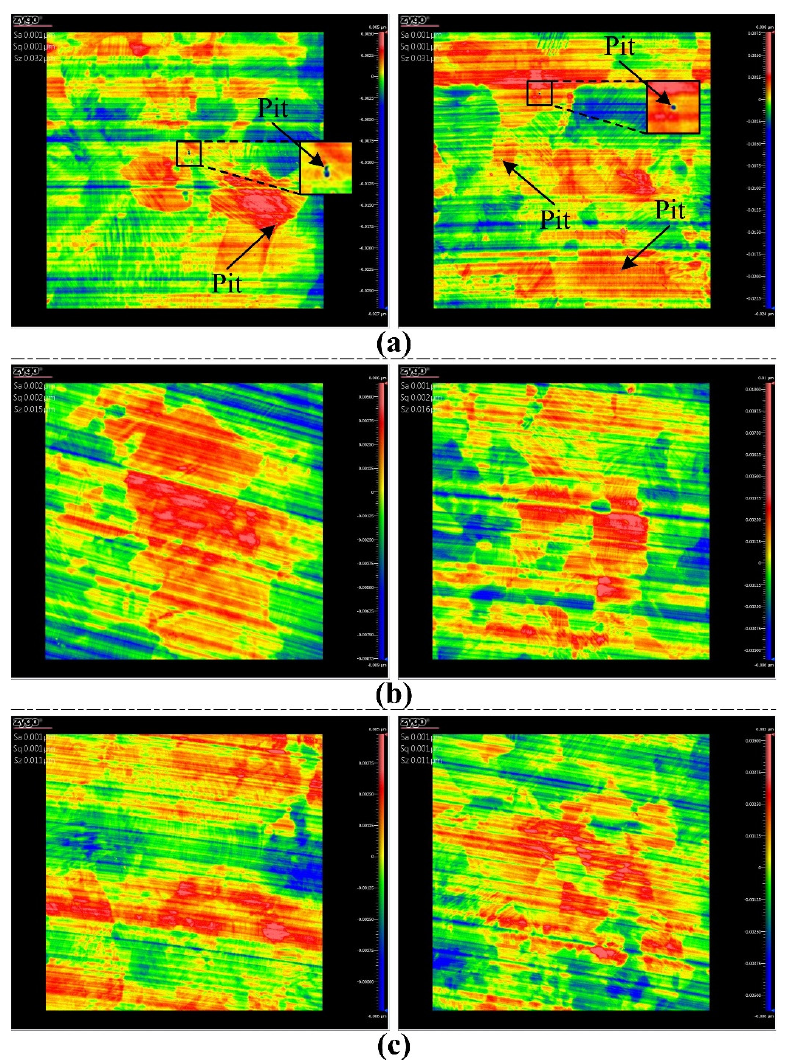
Figure 10. Surface morphologies cut by tool 1 at ( a ) 1.8 mm/min ( f = 0.6 μ m/rev), ( b ) 1.5 mm/min ( f = 0.5 μ m/rev), and ( c ) 1.2 mm/min ( f = 0.4 μ m/rev) feed rates under the same spindle speed (3000 rev/min) and cutting depth (2.5 μ m).